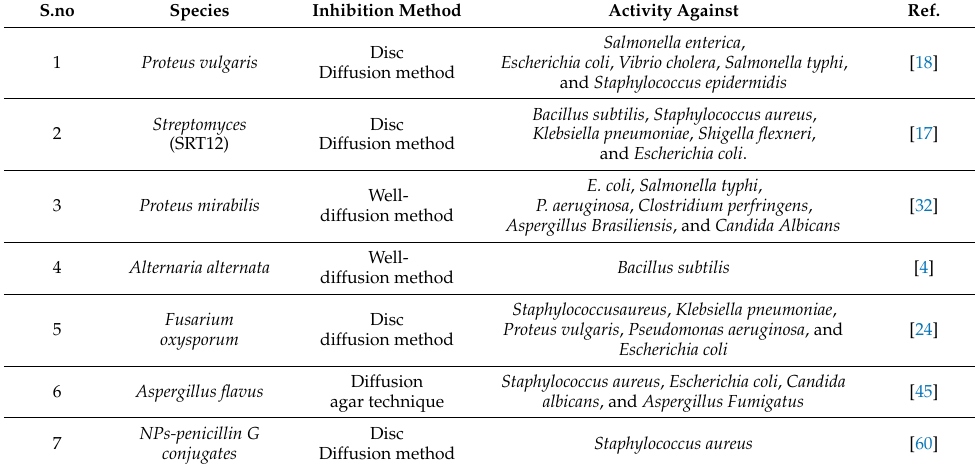
Table 3. Microbial species tested against various microbes mediated IONP